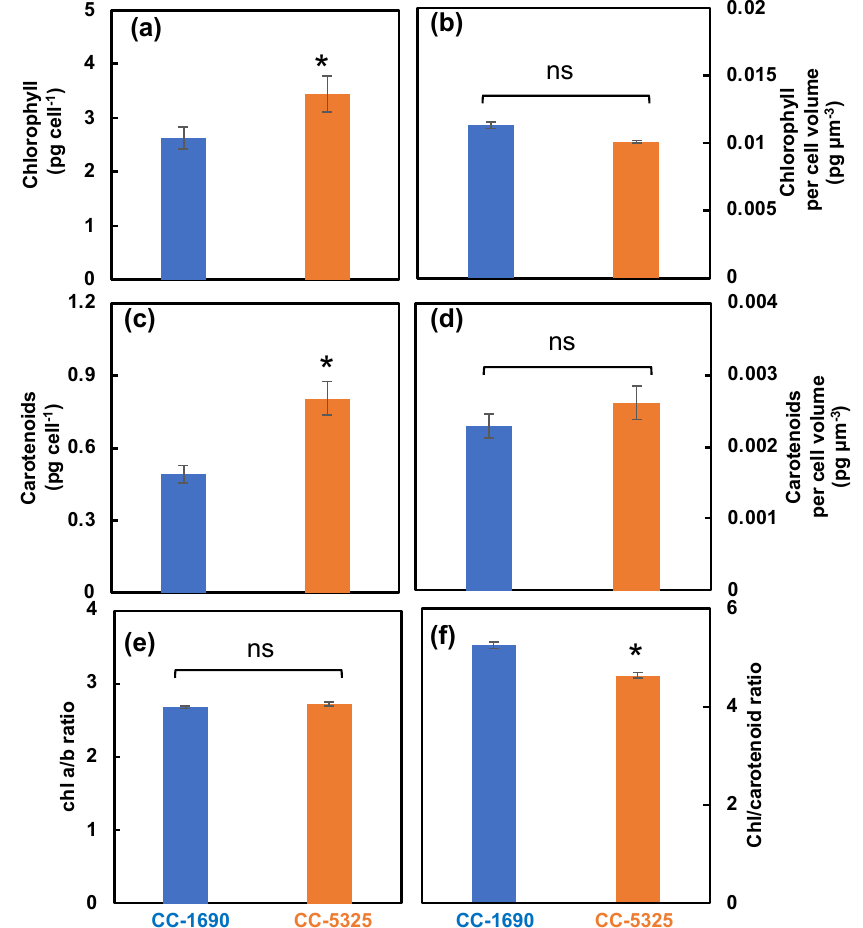
Figure 3. CC-5325 had more chlorophyll and carotenoids per cell than CC-1690, mainly due to the larger cell volume of CC-5325. Chlorophyll and carotenoids measured by absorbance change using a spectrophotometer. ( a , b ) Chlorophyll content per cell and per cell volume, respectively. ( c , d ) Carotenoid content per cell and per cell volume, respectively. ( e ) Chlorophyll a/b ratio. ( f ) Chlorophyll/carotenoid ratio. Mean ± SE, N = 3 biological replicates. Statistical analyses were performed using a two-tailed t -test assuming unequal variance by comparing with CC-1690: *, p < 0.05; ns, not significant.